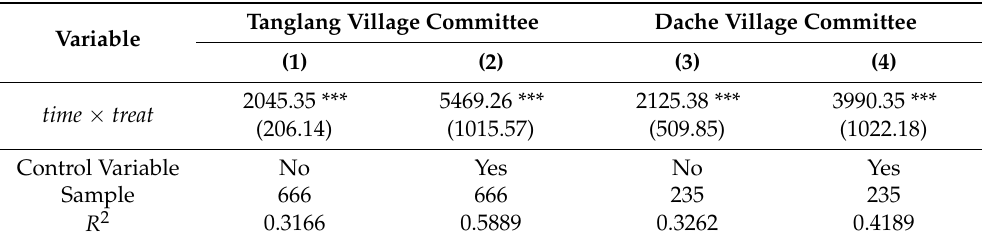
Table 7. Impact of Promoting Sorghum Planting Policy on per Capita Net Income of Households: Estimation Results Based on DID Model.